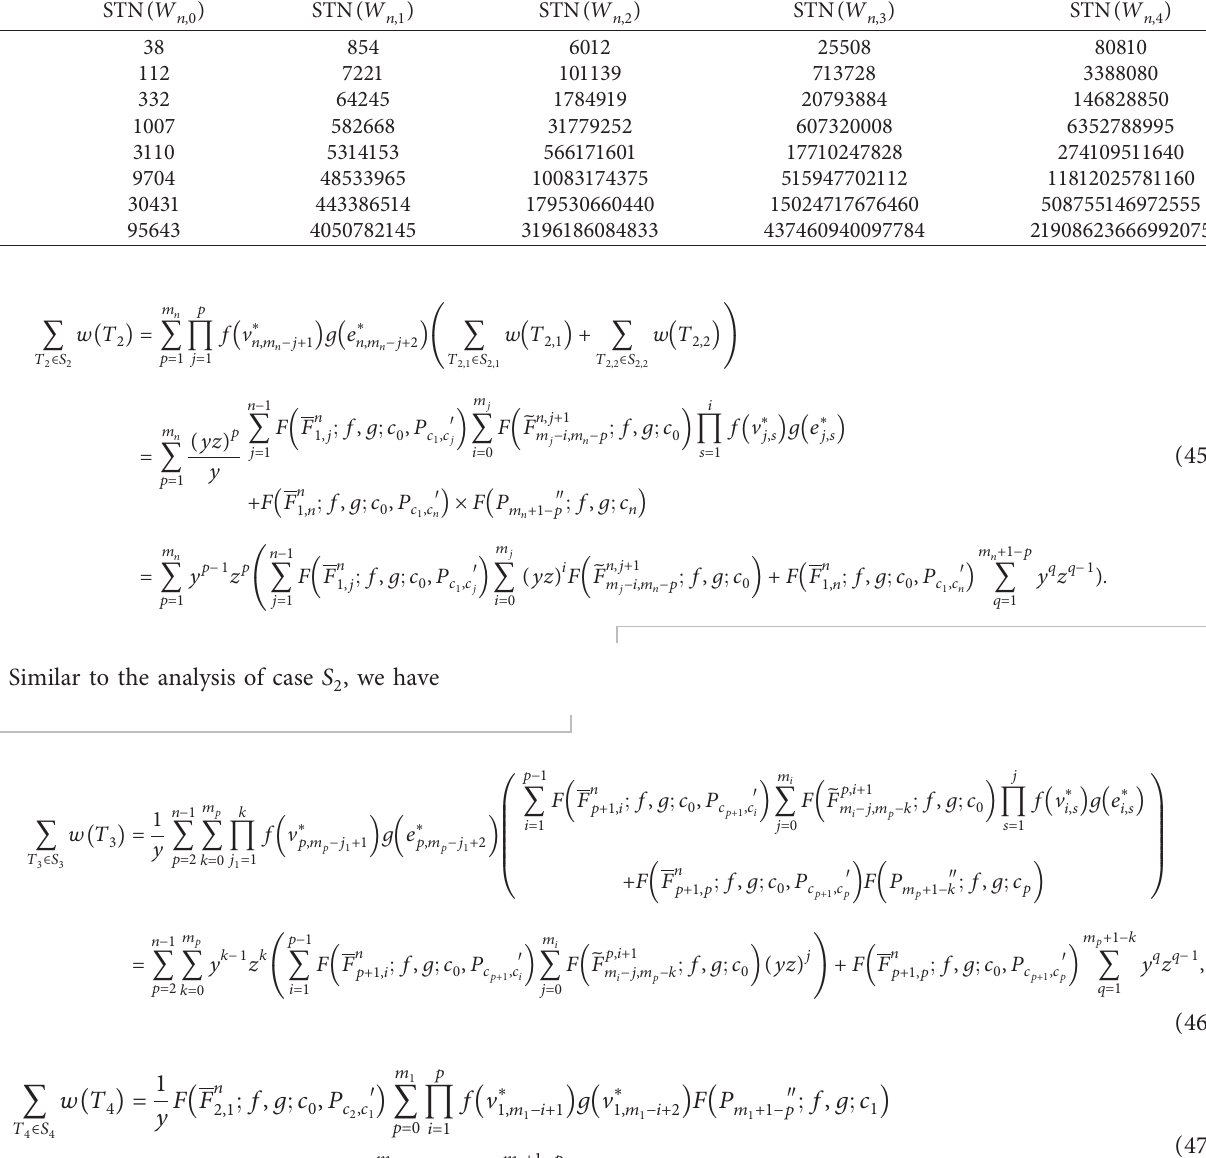
( n � 3 , .. . , 10 ; k � 0 , 1 , ... , 4 ) n,k